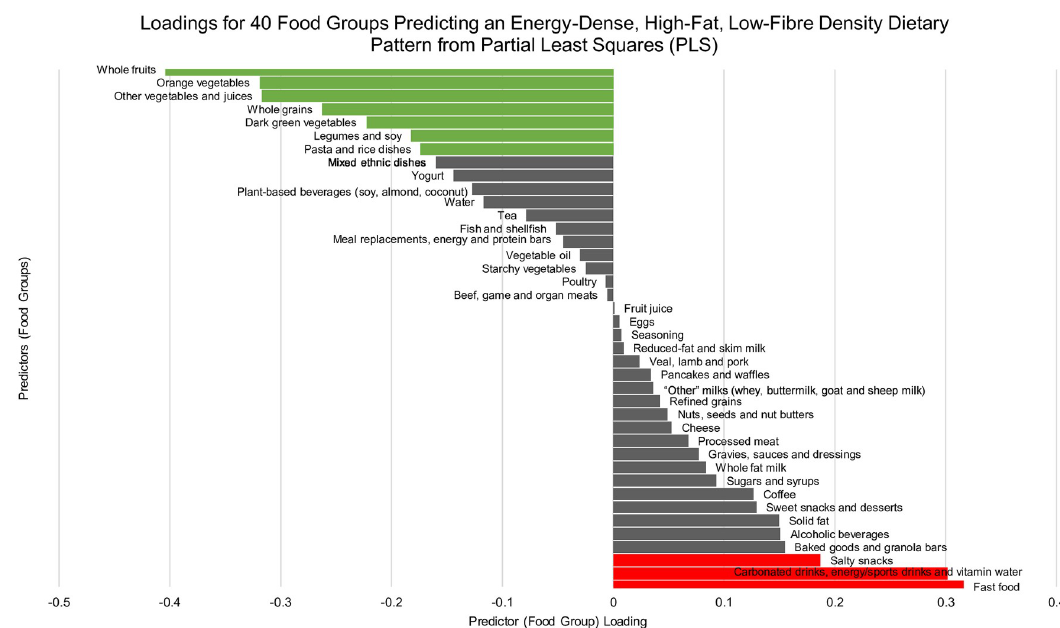
Fig 1. Predictor loadings for the energy-dense, high-fat and low-fiber density (“obesogenic”) dietary pattern derived from a weighted partial least squares (PLS) analysis in adult participants of the Canadian Community Health Survey 2015 ( n =